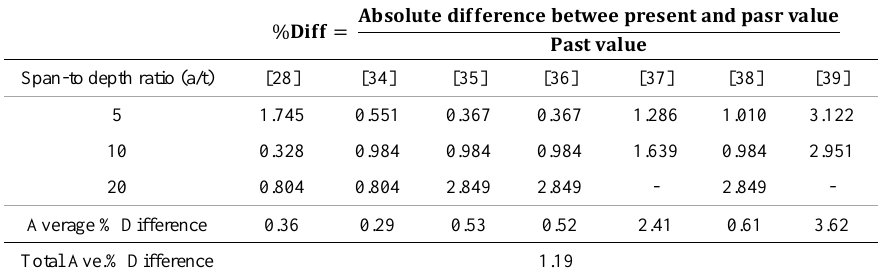
Table 3. Percentage difference between the present study and past